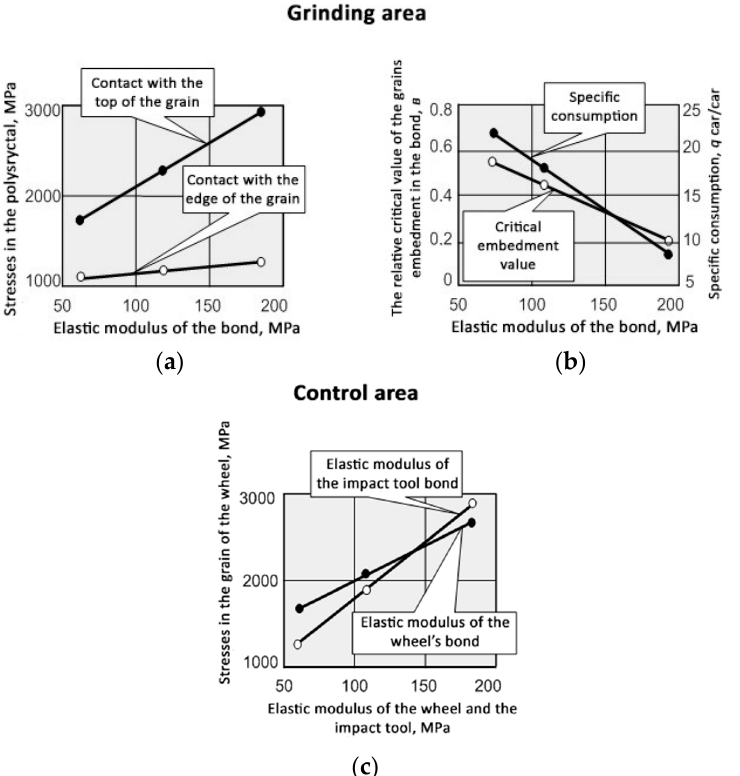
Figure 5. The effect of the elastic modulus of the bond between the wheel and the impact tool on the stresses in the SHM ( a ) for the grain, ( b ) the critical value of the embedding of grains into the bond and the specific consumption, and ( c ) the relative critical value of the embedding of the grain in the bond b = h cr / l , l –maximum grain size, μ m.